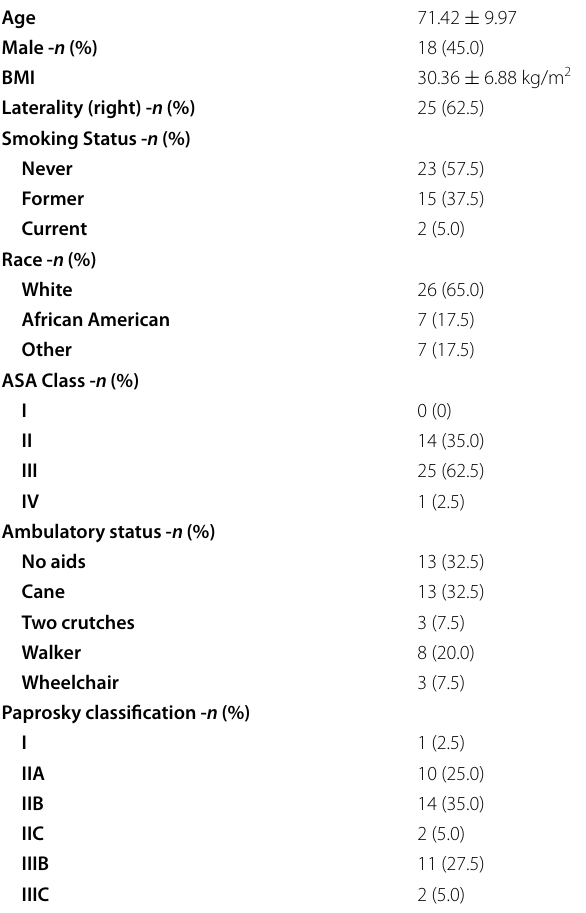
ASA American Society of Anesthesiologists, BMI Body mass index, n